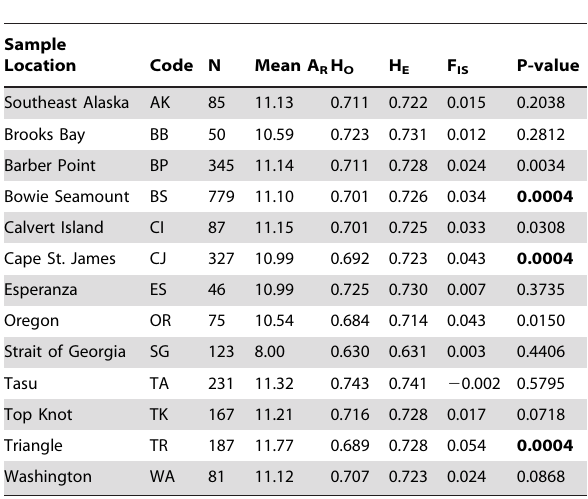
Table 1. Sample location specific descriptive statistics.